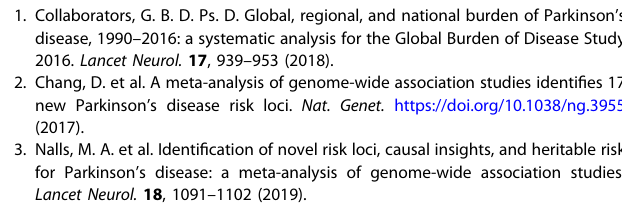
Table 4 for Prevotella . Individual-level SNP (2,627 SNPs) and phenotype data (sex, age, case/control) that were used in this paper (the SNCA region) are provided in Supplementary Table 5. The full genome-wide genotypes and phenotype (not used in this article) will be available on dbGaP (accession code phs000196) one year from publication of this article to allow authors time to analyze the